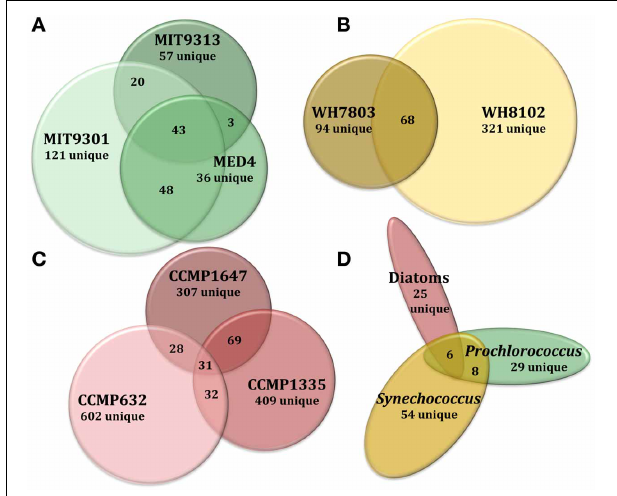
FIGURE 3 | Venn diagrams comparing DOM P composition at several levels of phylogenetic variation for all eight phytoplankton strains tested in this study. Features common to all replicate cultures for a given strain are represented by circles or ellipses, the area of which is proportional to the total number of features identified as common for that strain. The degree of overlap between shapes is proportional to the number of shared features between strains of Prochlorococcus (A) , Synechococcus (B) , and diatoms (C) . Features common to each of these 3 broad phytoplankton groupings were also compared (D) to examine variation at the genus and domain levels. For more detailed information regarding percentages of shared DOM P features among different strains, see Table 4